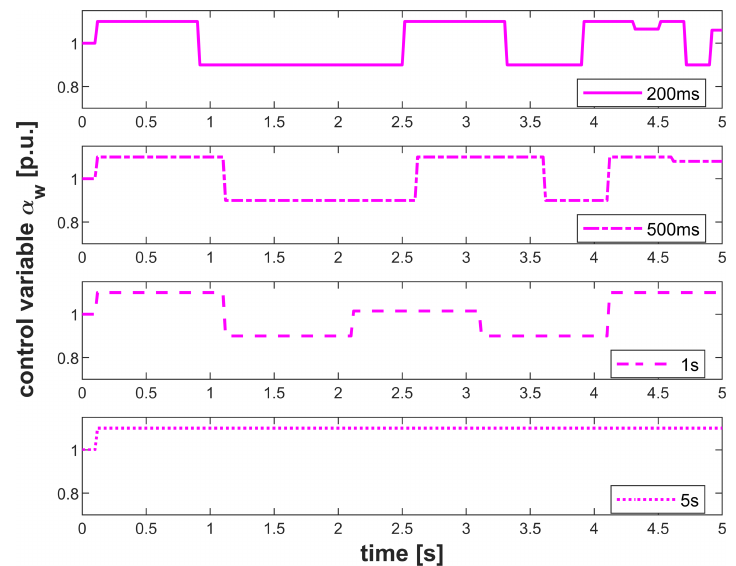
Figure 14. Control action applied to the D-FACTS in Villanova-Montalto with different control time